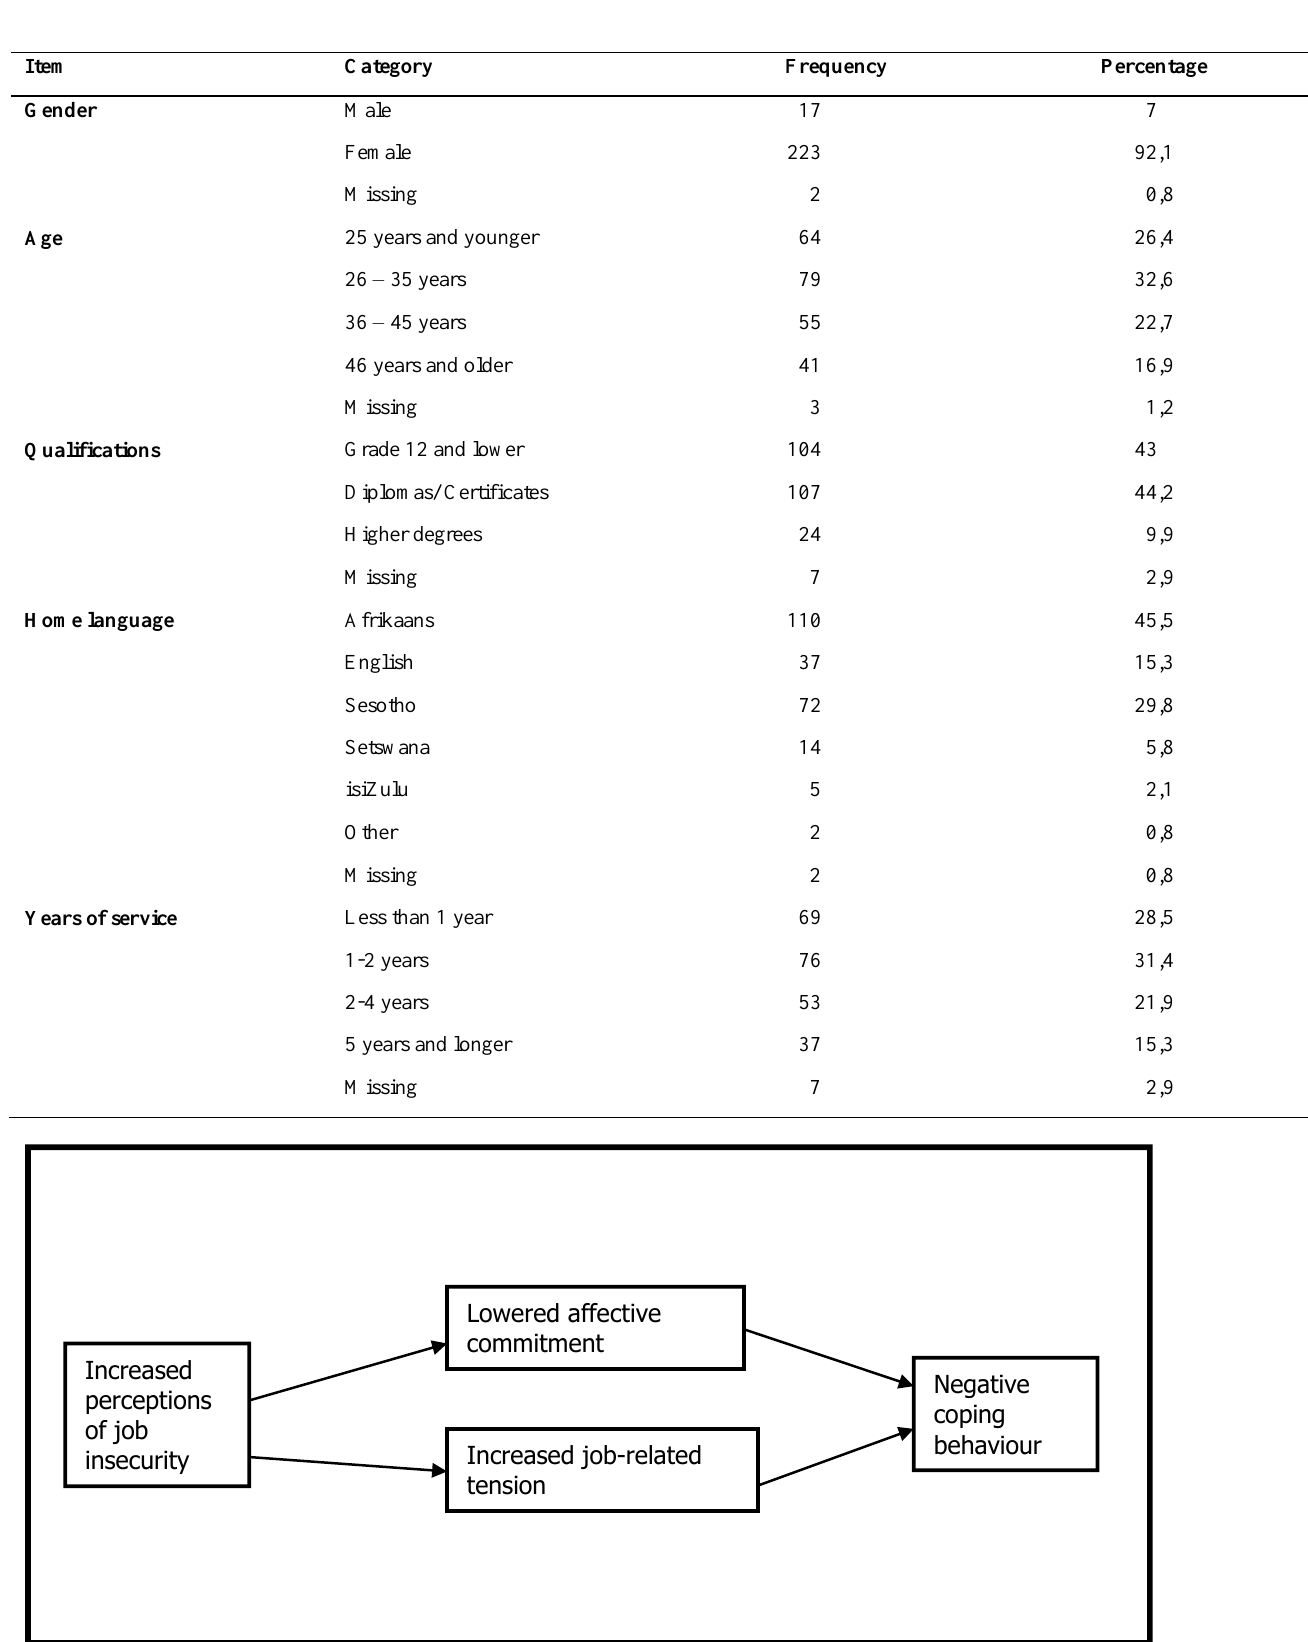
Table 1: Biographical characteristics of the participants ( N = 242)